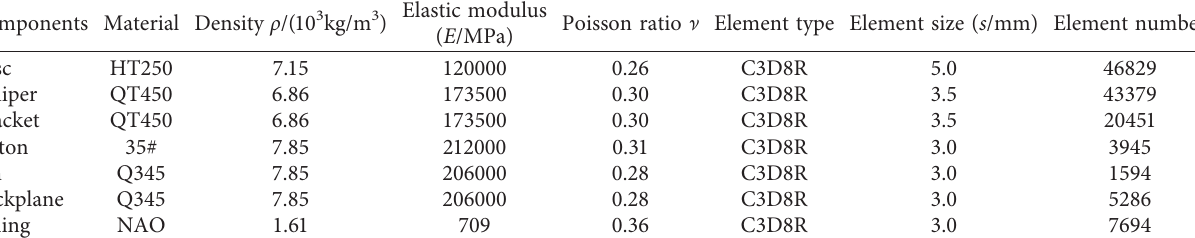
Figure 1: Original and finite element model of the brake system. Table 1: Properties of components in the brake system finite element model.